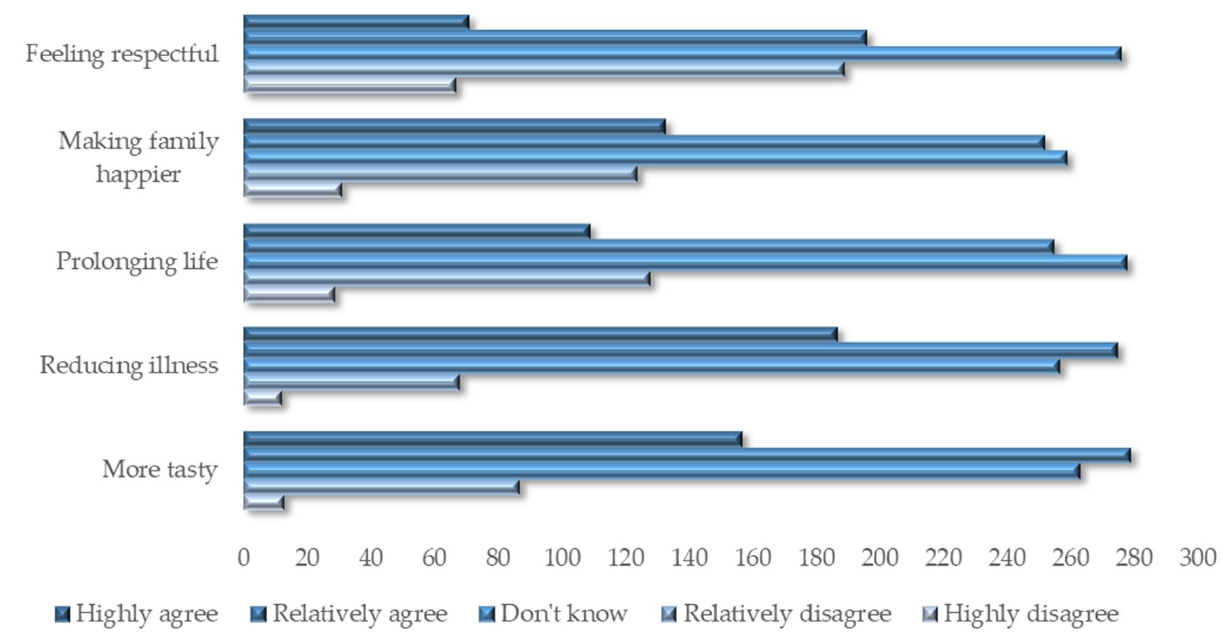
Figure 4. Respondents’ perception of various benefits of organic food.